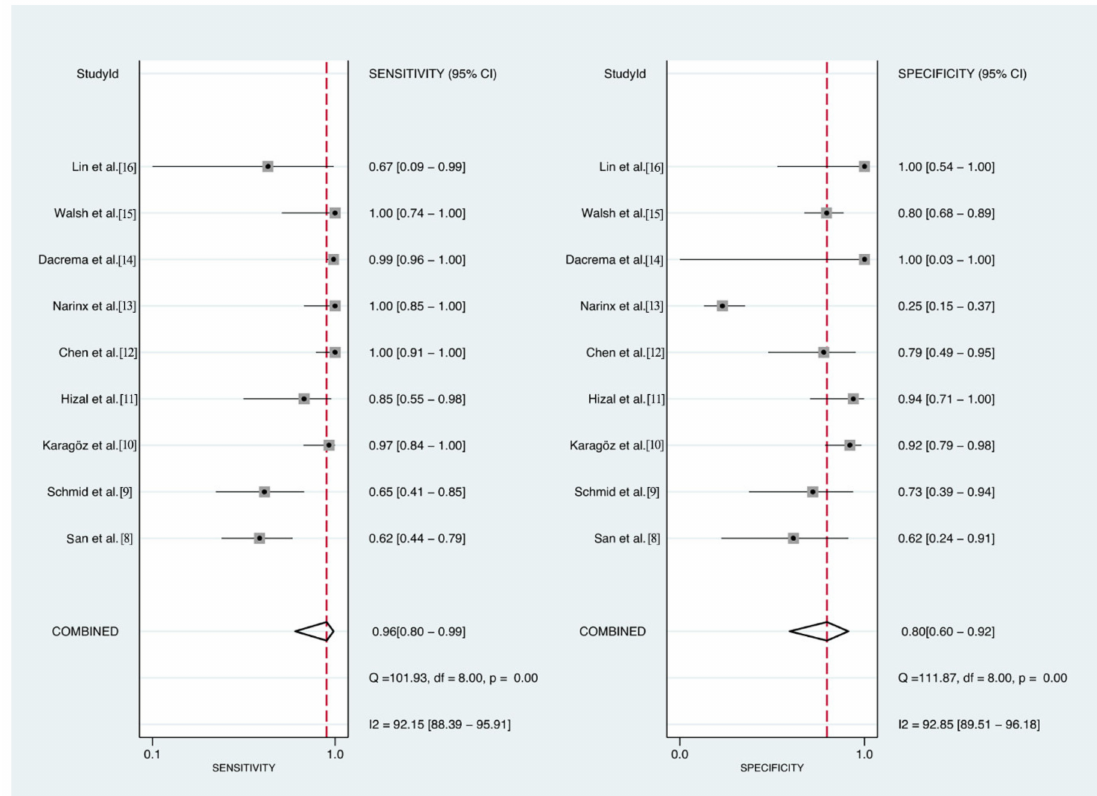
Figure 3. Positive ( left panel) and negative ( right panel) percent agreement of lung ultrasound for the diagnosis of interstitial pneumonia caused by